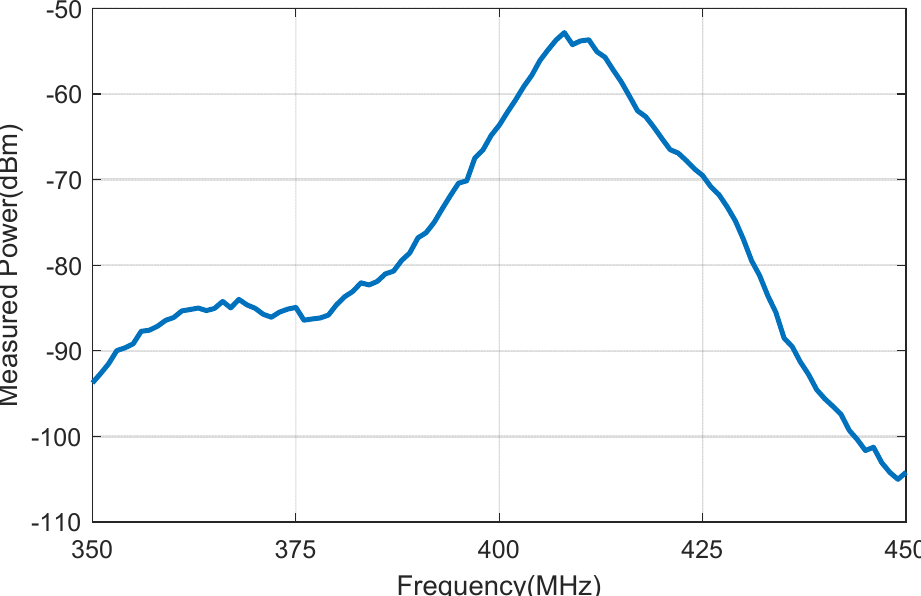
Figure 19. First harmonic (f c + f m ) measured power as a function of the frequency with the backscatter immersed in the vessel described in Figure 17.